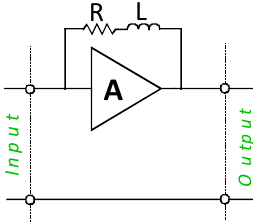
Figure 1: Amplifier in feedback with an RL-series